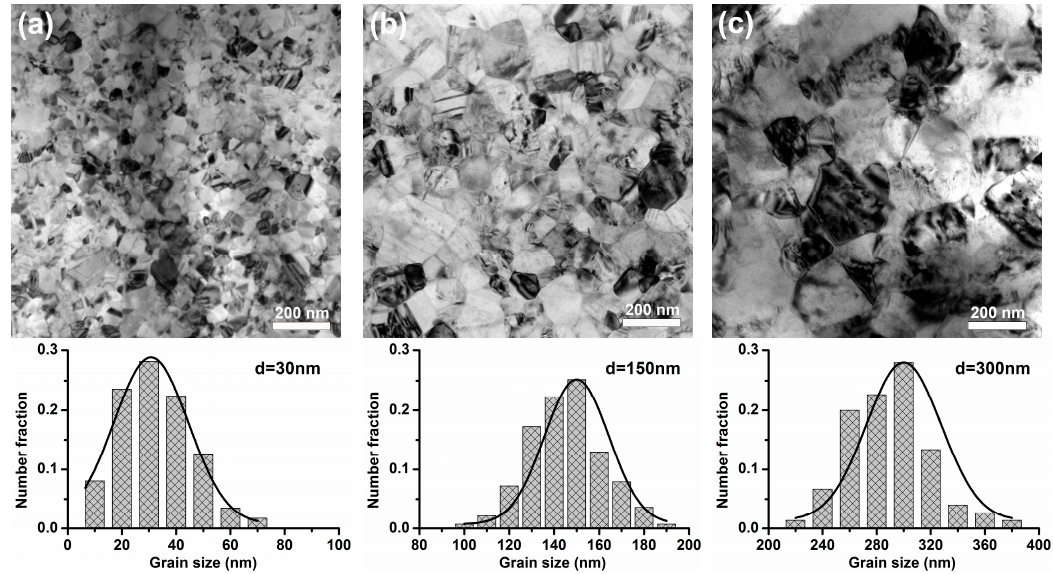
Figure 1. TEM bright-field images of the as-brush-plated NC/UFG Cu: ( a ) 30 nm Cu; ( b ) 150 nm Cu; ( c ) 300 nm Cu.